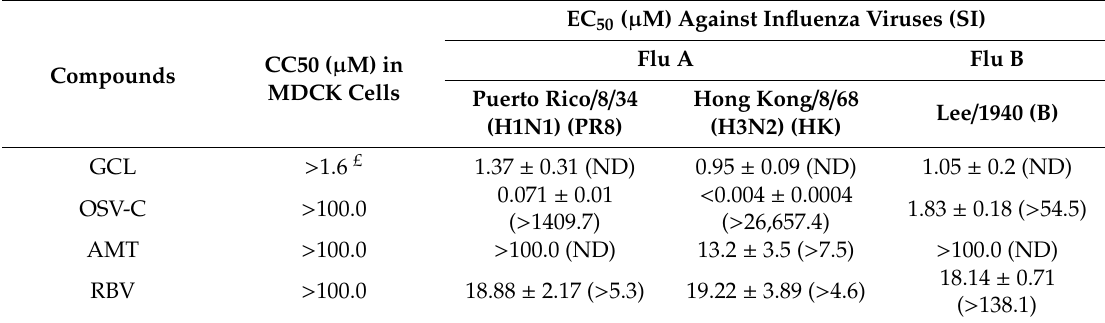
Table 5. Antiviral activity of Grateloupia chianggi lectin (GCL) against influenza virus strains.